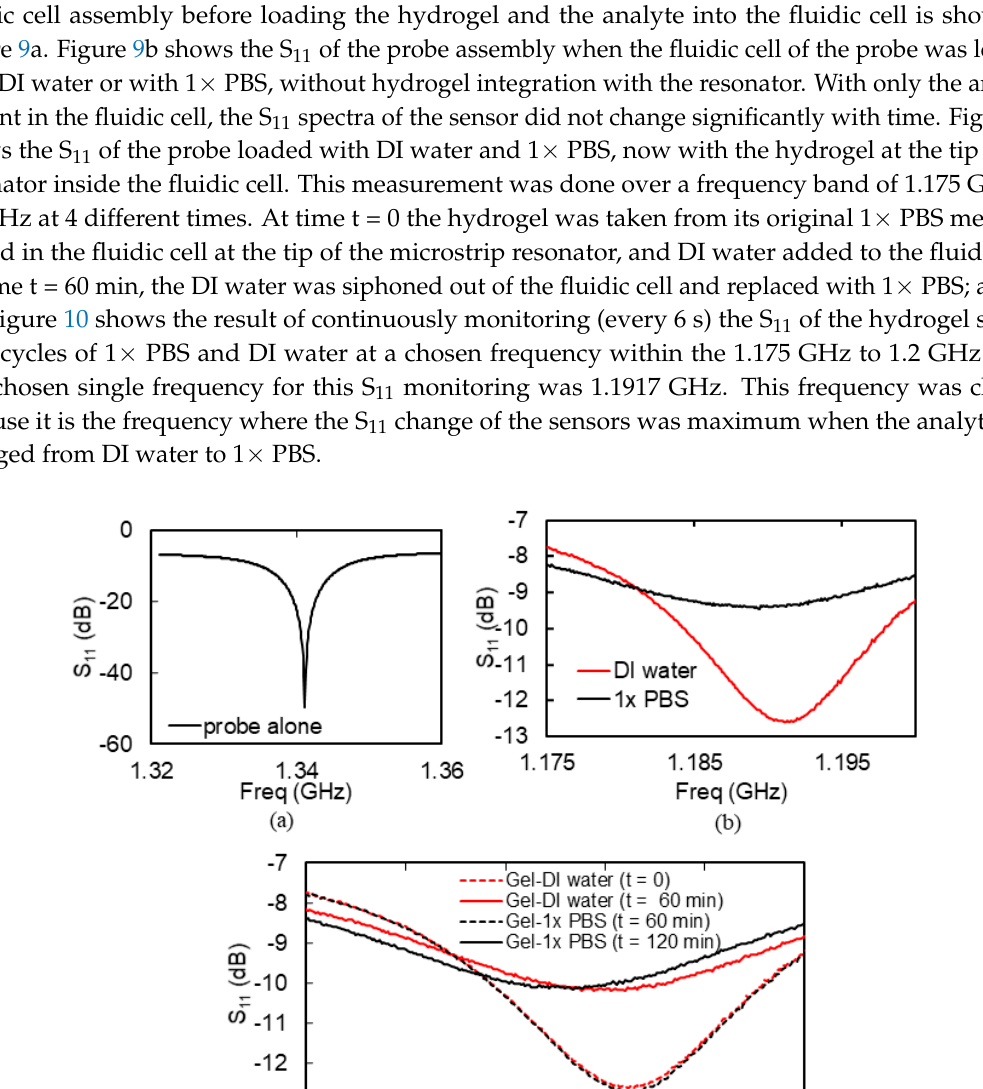
Figure 8. Impedance of the hydrogel sensor as a function of time as solutions with different ionic concentrations were introduced. ( a ) Hydrogel sensor capacitance in response to deionized (DI) water or 1× PBS. ( b ) Hydrogel sensor resistance in response to DI water or 1× PBS.